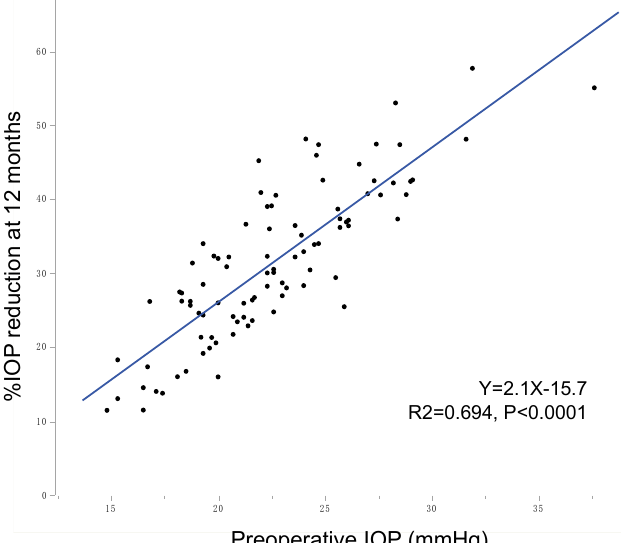
Figure 2. Correlation between preoperative and postoperative 12 months IOP after various ab interno goniotomy procedures in the published literature. A full list of studies is found in Supplementary Table S1. Blue line and area indicate linear regression and 95% confidence intervals, respectively.